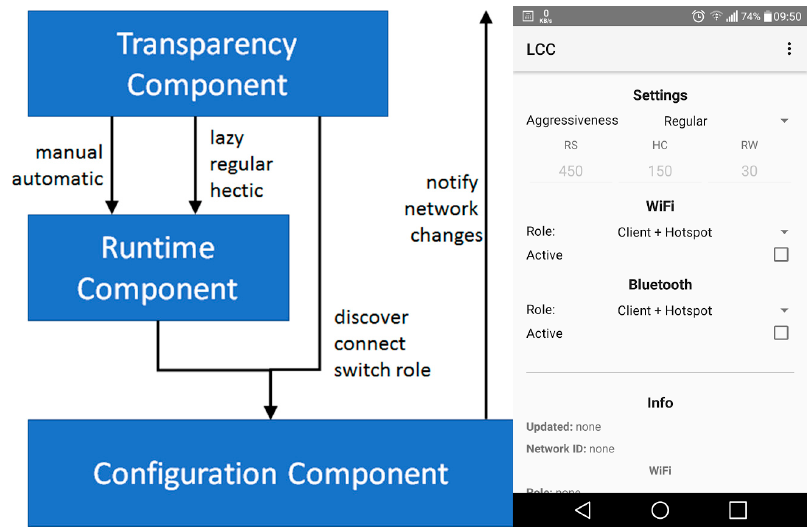
Figure 2. Link Connectivity Component (LCC) architecture ( left ) and Android GUI ( right ).